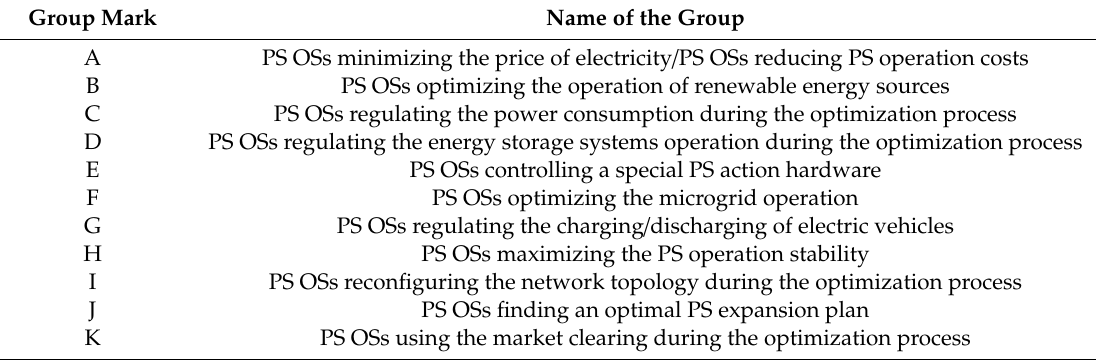
Table 1. Topics of 11 identified electrical power system (PS) optimization systems (OSs)